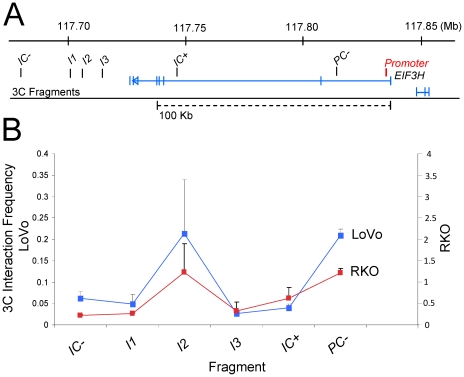
Physical interaction of the CRC variant rs16888589 with EIF3H in CRC cell lines.(A) Physical map of the region interrogated by 3C. The position of the constant fragment at the EIF3H promoter is shown in red. Genomic positions of target fragments (Table S3) are denoted by black bars. (b) Graph showing the 3C interaction frequency containing the promoter with each target fragment in the LoVo and RKO CRC cell lines. Error bars represent SEM. The results demonstrate increased interaction frequency in the cell lines between the EIF3H promoter and fragment I2 to which rs16888589 maps. The Y-axis refers to interaction frequency; RKO to the right; LoVo to the left. The assay was performed independently for two and three times in RKO and LoVo colorectal cancer cell lines, respectively. Labels at each data point in the graph denote the name of each target fragment.